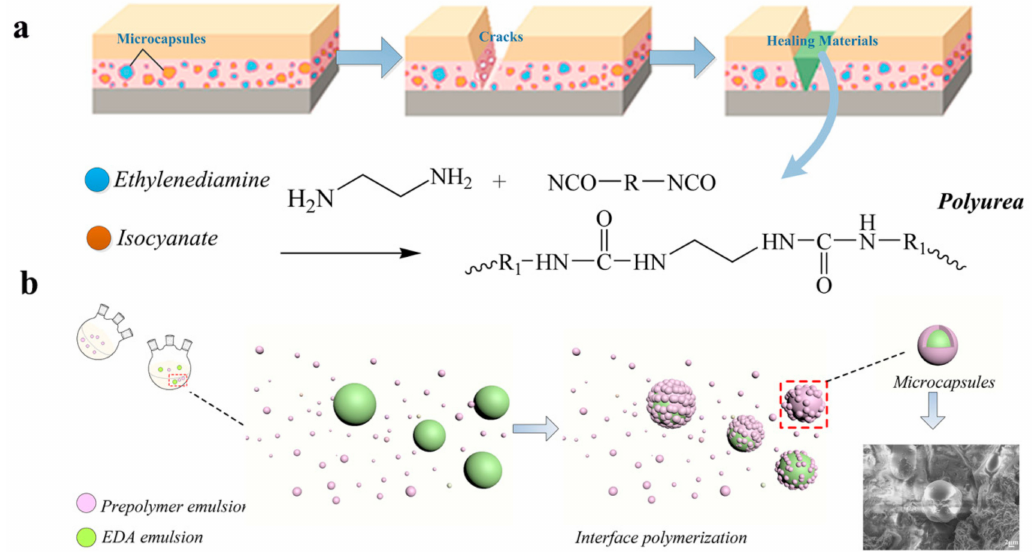
Figure 1. ( a ) Molecular structure and self-healing mechanism of EDA-Polyurea microcapsule; ( b ) Preparation process of EDA-Polyurea